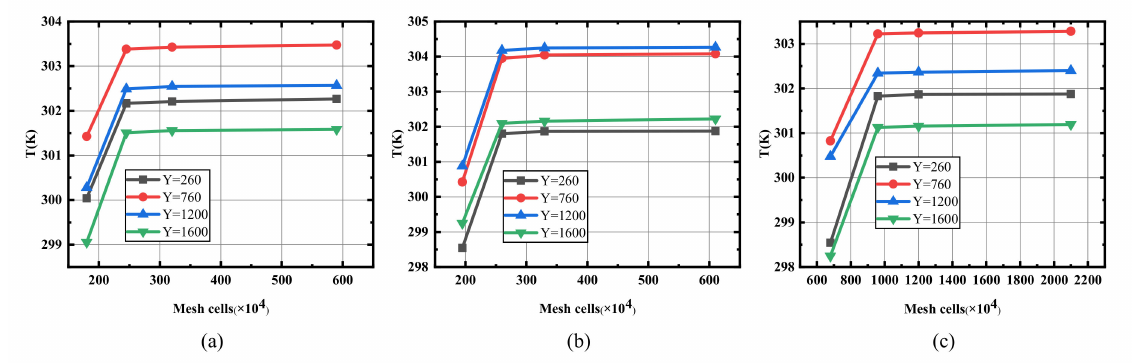
Figure 6. Analysis of grid independence. ( a ) Traditional 120 ◦ lower air supply; ( b ) Traditional 45 ◦ upper air supply; ( c ) New air cooling